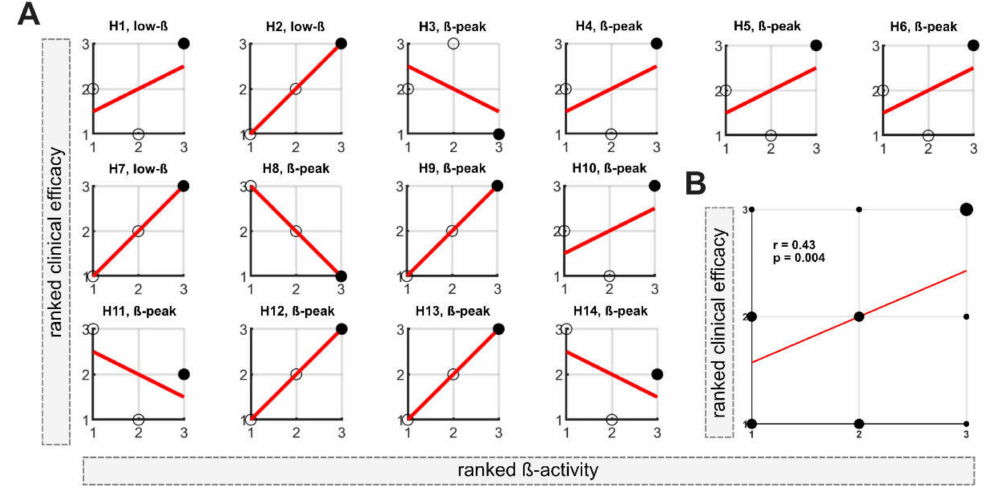
Figure 3. Determination of the best directional contact: ( A ) Correlation between ranked clinical efficacy (improvement in UPDRS-III items 22, 23 and 25) and ranked weighted ß-activity for each hemisphere (H1-H14). The filled black dots correspond to the level with the highest beta activity. n per hemisphere = 3. #1 = the lowest rank; #3 = the highest rank. ( B ) At the group level, ranked beta activity correlated with ranked beta activity using Spearman’s correlation (n = 42). Larger dots indicate multiple data points. #1 = the lowest rank; #3 = the highest